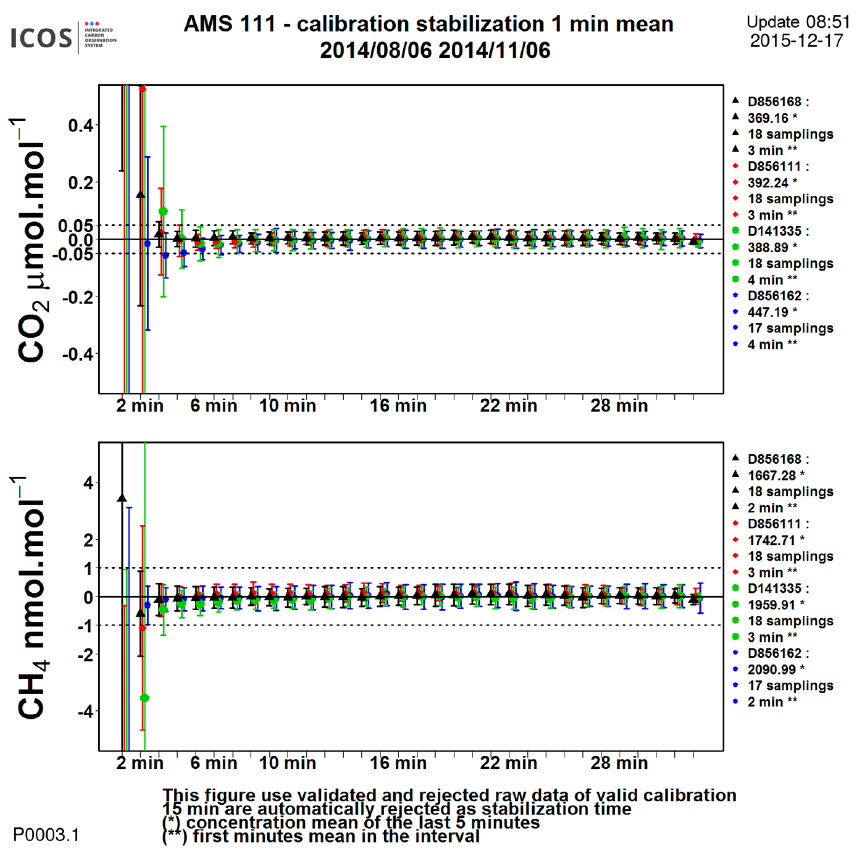
Figure 3. CO 2 (above) and CH 4 (below) mole fraction differences between each minute and the last minute of the target gas measurement period (30min in this case) at the Amsterdam Island station (identified by the three-letter code AMS). The differences are averaged for all target gas measurements from 6 August to 6 November 2014. The number of injections or samplings during this period is provided for each of the four target gases on the right. The minutes provided on the right of the graph for each gas correspond to the minute when the difference decreases below the horizontal dashed lines chosen as half the WMO-recommended compatibility for northern hemispheric sites